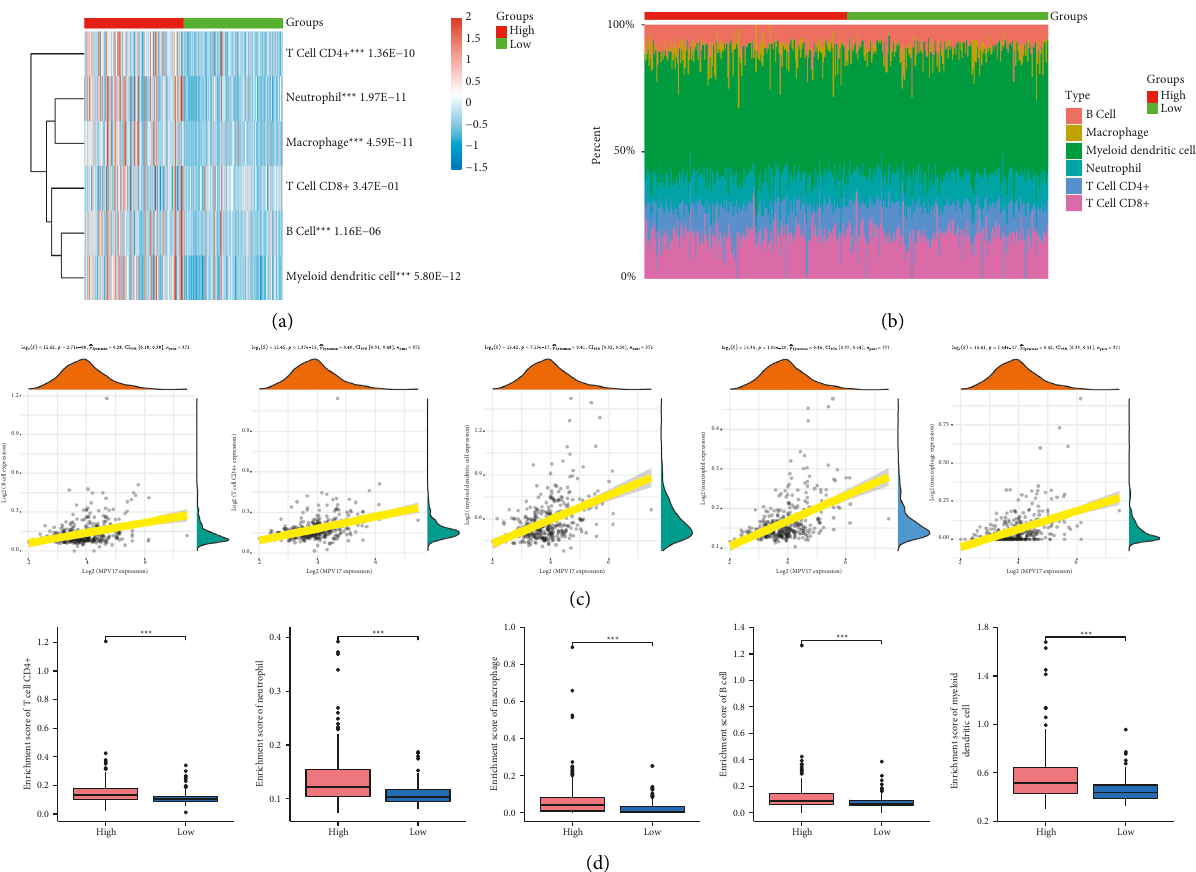
Figure 7: Correlation analysis between MPV17 and immune cells. (a) Different expressions of immune cells in high-expressed and low- expressed MPV17 groups. (b) The percentage abundance of tumor-infiltrating immune cells in each sample. (c) Spearman’s correlation analysis between MPV17 and immune cell expression. (d) Enrichment scores of immune cells in high- and low-expressed MPV17 groups. Immune cells with high MPV17 expression also had higher enrichment scores. ∗ ∗ ∗ P < 0 . 001.